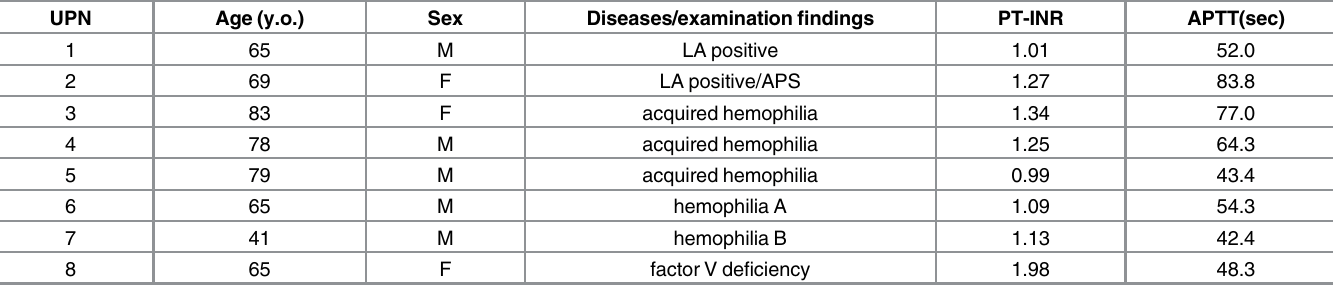
Table 1. Characteristics of the patients with prolonged APTT.